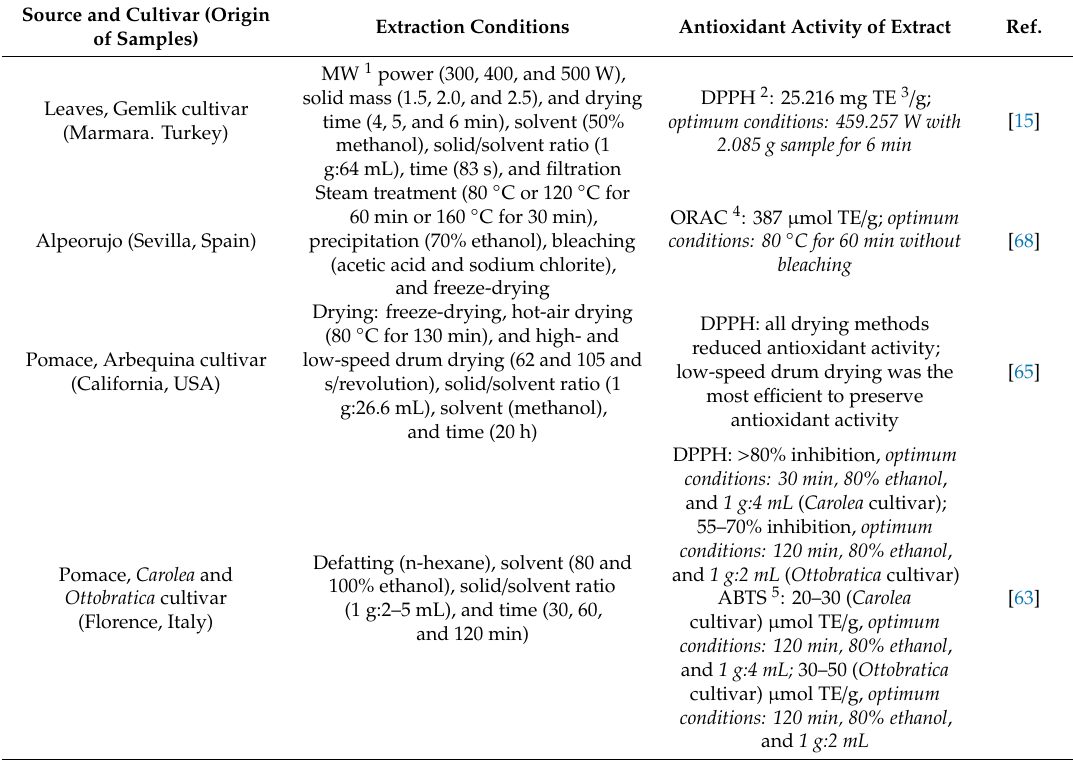
Table 2. Antioxidant activity in vitro of di ff erent parts of Olea europaea and olive oil by-products. Source and Cultivar (Origin Extraction Conditions Antioxidant Activity of Extract of Samples)